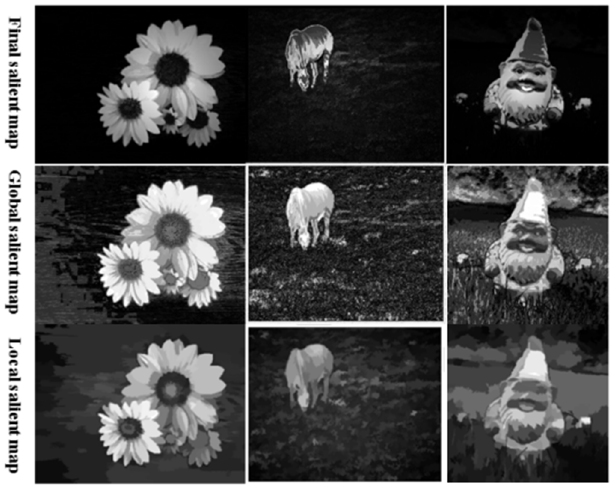
Figure 9. The combined result compared with the saliency obtained by LTRSH and global saliency; from top to bottom: the final combined result, global saliency produced using the global color, and saliency obtained by